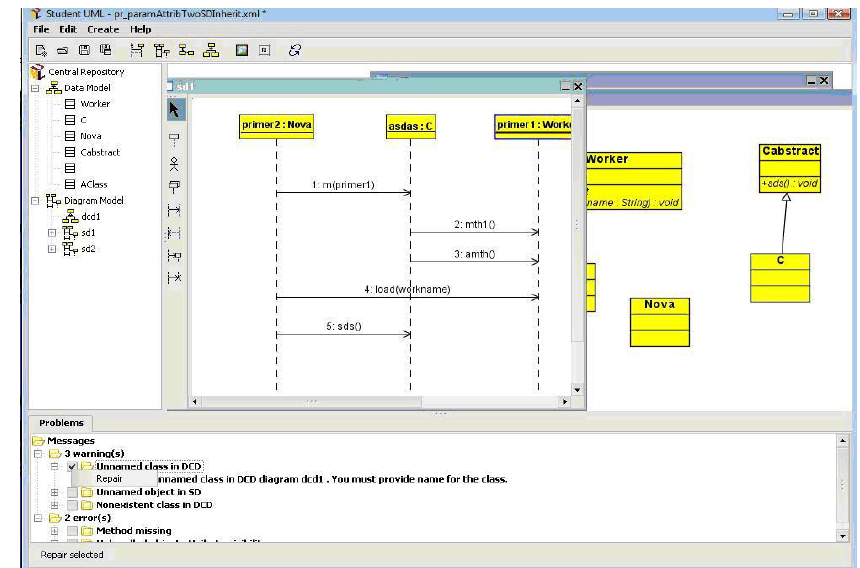
Figure 4. Screenshot of the standalone version of the StudentUML modeling tool.